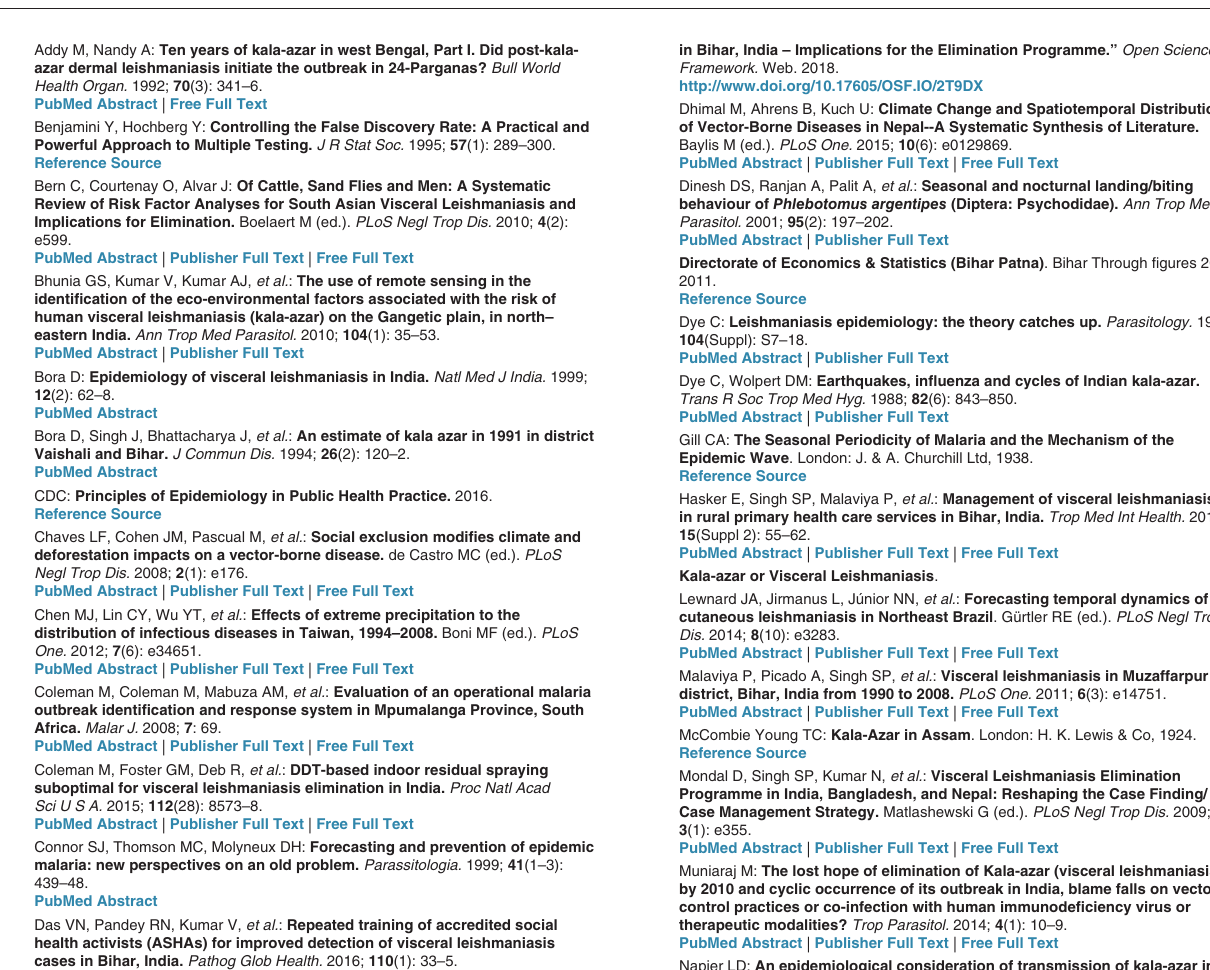
Supplementary Table 2: Summaries of the models fitted to climate anomalies for the period 1977–2013. Click here to access the